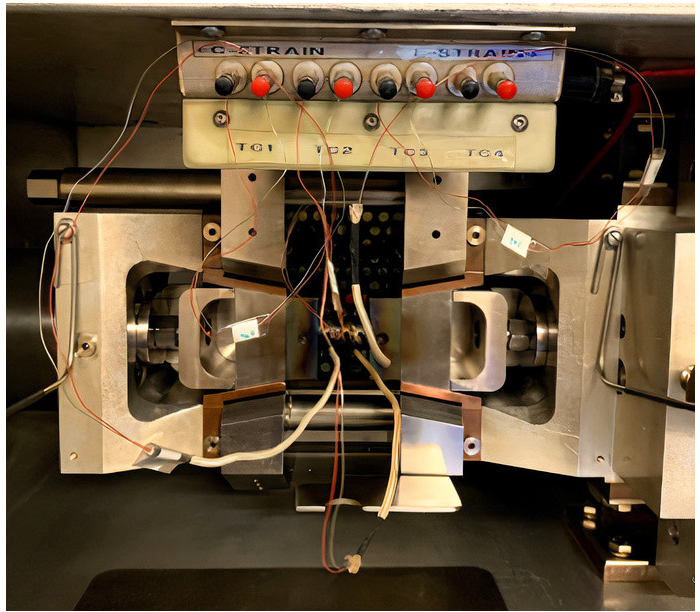
Figure 2. The inside of the Gleeble-3800 thermomechanical simulator with the specimen in place. As shown in Figure 3, the samples were heated to a temperature of 1260 ◦ C with a heating rate of 2 ◦ C/s and held at this temperature for 5 min to eliminate thermal gradients. They were then cooled down with a rate of 1 ◦ C/s to the test temperature and then held at constant temperature for 1 min before deformation. During the compression phase, the temperature of the specimen is kept constant by the thermal control system of the machine. After compression, the specimen is quickly quenched to freeze its microstructure for later analysis. Figure 3 also shows the aspects of the specimens before and after the compression test: h 0 and r 0 are the height and radius before compression and h , r m , and r t are the height, large radius, and small radius of the specimen after compression, respectively.